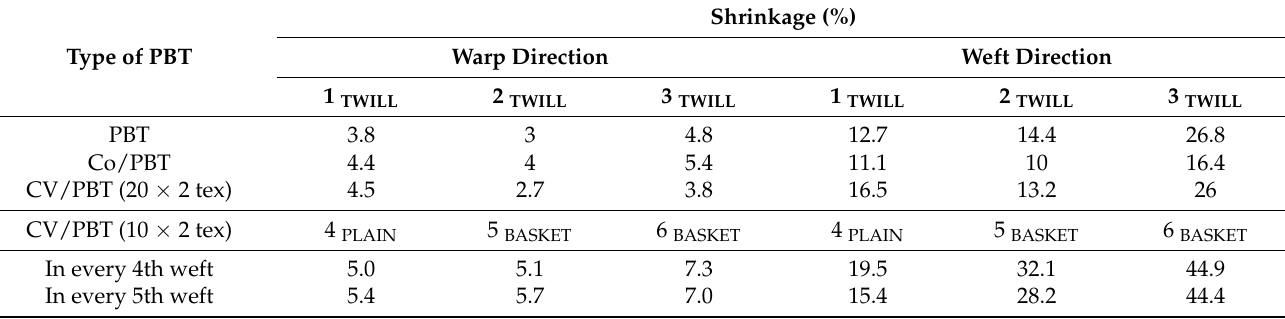
Table A6. Shrinkage of samples after treatment in warp and weft